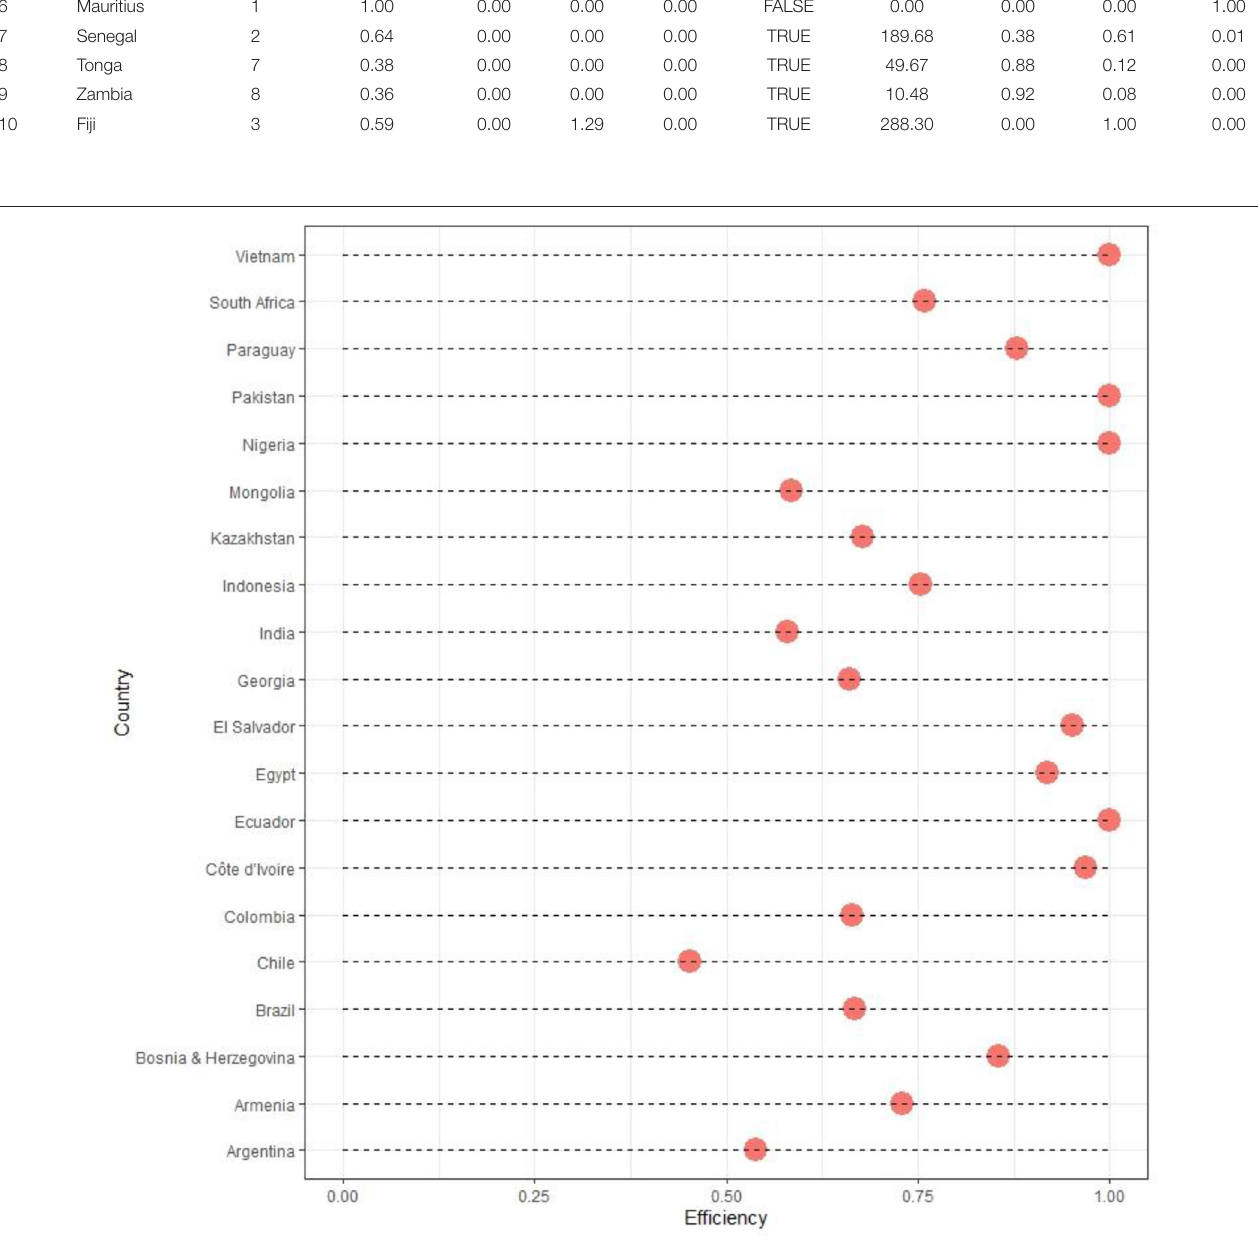
FIGURE 2 | DEA-BCC efficiency scores for Cluster 2-countries (The each red dot represents the efficiency score of the respective country. On a scale 0–1.0, higher score refers to better emission mitigaton performance).